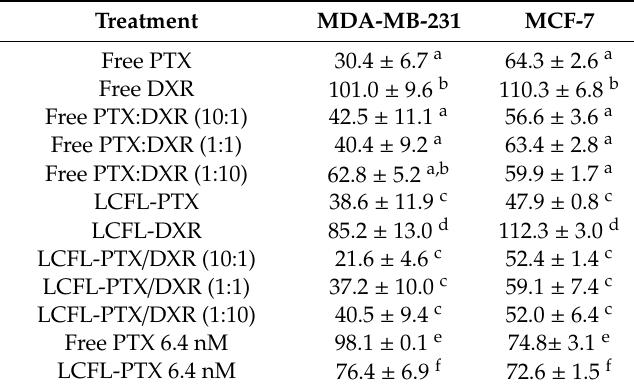
Table 3. Percentage of cellular migration in relation to the control for the di ff erent cell lines evaluated when exposed to di ff erent ratios of free or liposome co-encapsulated PTX and DXR at total concentration of 70 nM for 24